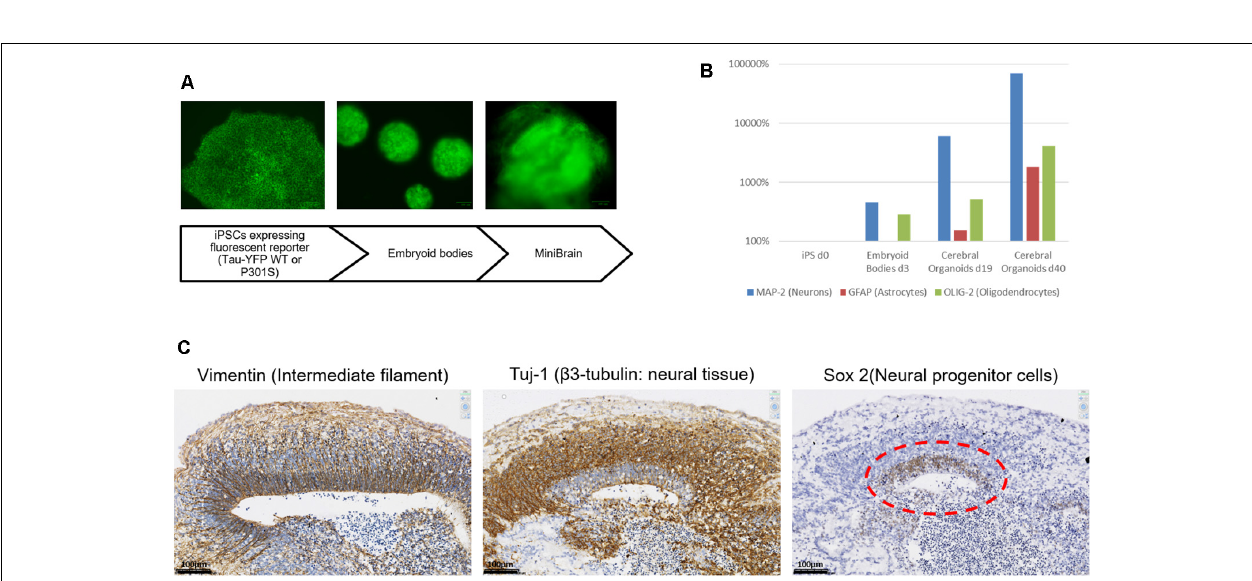
FIGURE 2 | Pluripotency characterization of transgenic iPSCs. (A) Assessment of pluripotency by semi-quantitative PCR to confirm the expression of pluripotency markers in the control iPS line BJ and in EBV-based plasmid expressing lines. PCR analysis shows the expression of pluripotency markers OCT4, SOX2, NANOG and REX-1. BJ fibroblasts were used as a control and RPLP0 as a housekeeping gene. (B) H&E staining of a section of teratomas obtained from iPSCs expressing either Tau WT or P301S using an EBV-based plasmid showing the development of structures specific to the three germ layers.